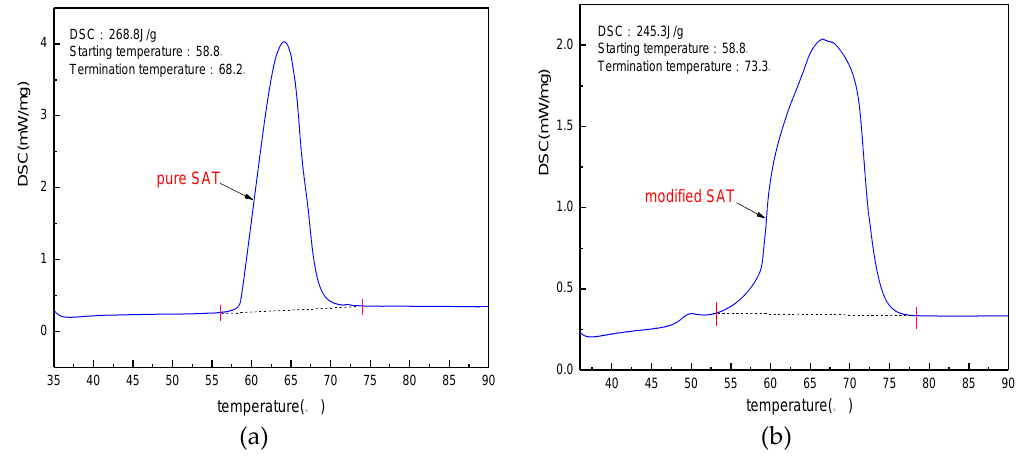
Figure 8. DSC curves of pure SAT and modified SAT. ( a ) pure SAT; ( b ) modified SAT.